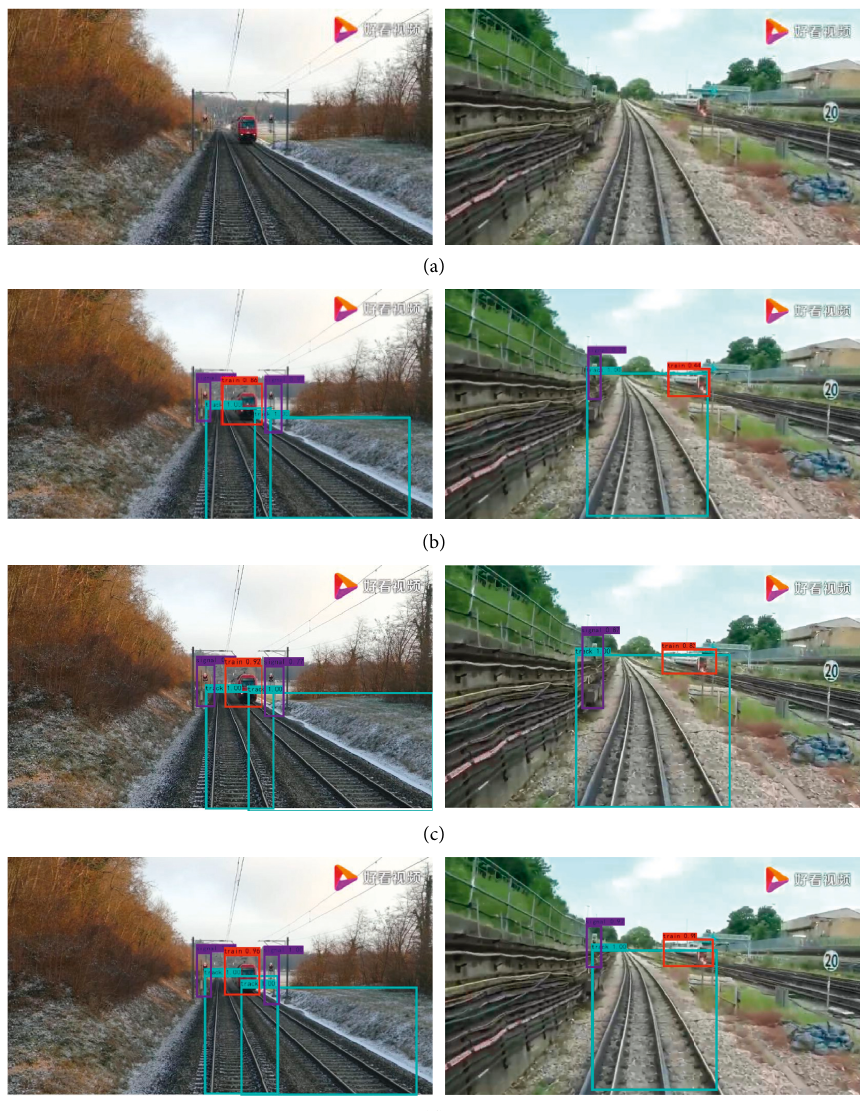
Figure 14: Image comparison of ablation experiments. (a) Original image. (b) YOLO V4. (c) MV3-YOLO-lite (NMS). (d) Soft-NMS MV3-